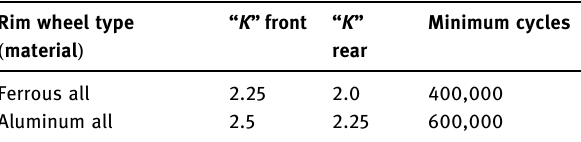
Table 4: Test factor and minimum cycle requirements for wheels